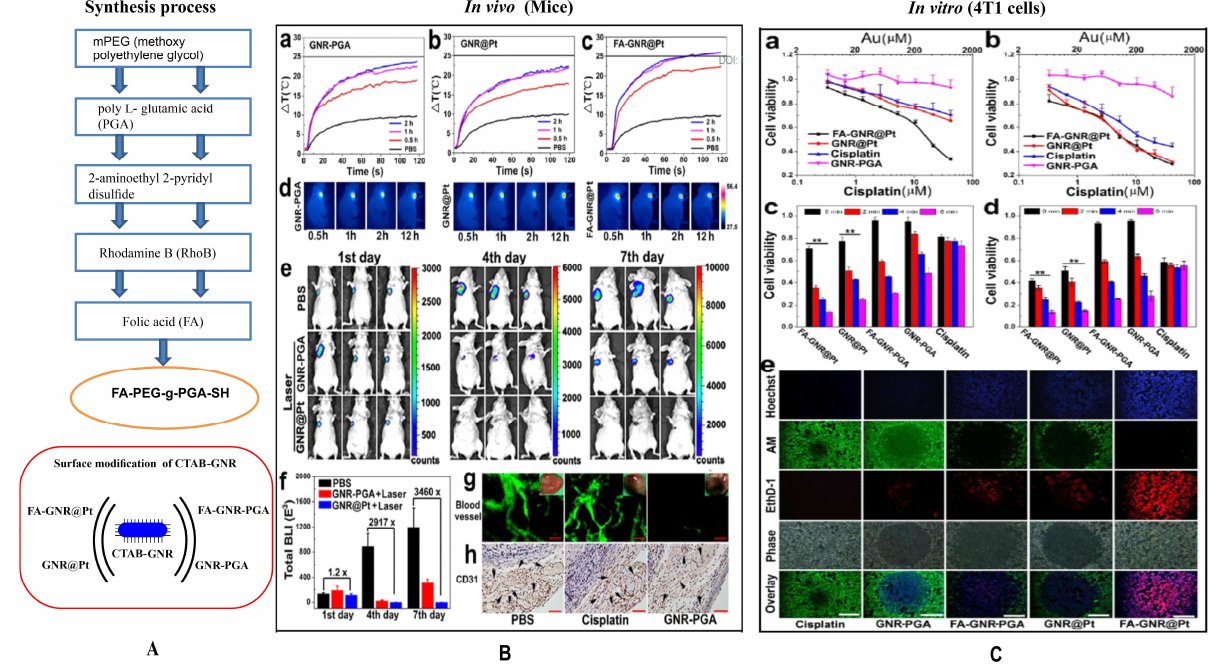
Figure 6. Gold nanorods coupled with various functional moieties for in vivo and in vitro photo- thermal treatment. ( A ) Surface modification of CTAB-GNR with folic acid (FA), cisplatin (Pt), and poly-L-glutamic acid (PGA) to synthesize thiolated poly (ethylene glycol)-graft-poly